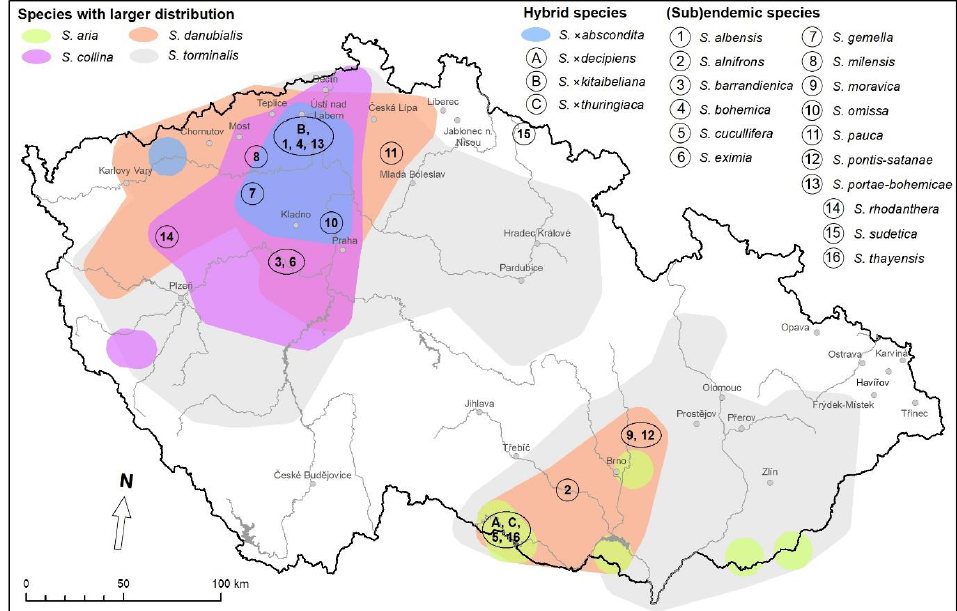
Figure 5. Map showing a distribution of Sorbus taxa in Czechia except for Sorbus aucuparia (it is widespread throughout the country). The areas of species with larger distribution were delineated with the “Sample by Buffered Local Adaptive Convex-Hull” tool [89], which combines the creation of a wrapper zone and a minimal convex polygon. Data on Sorbus species with larger distribution were derived from the Pladias database [14,90].